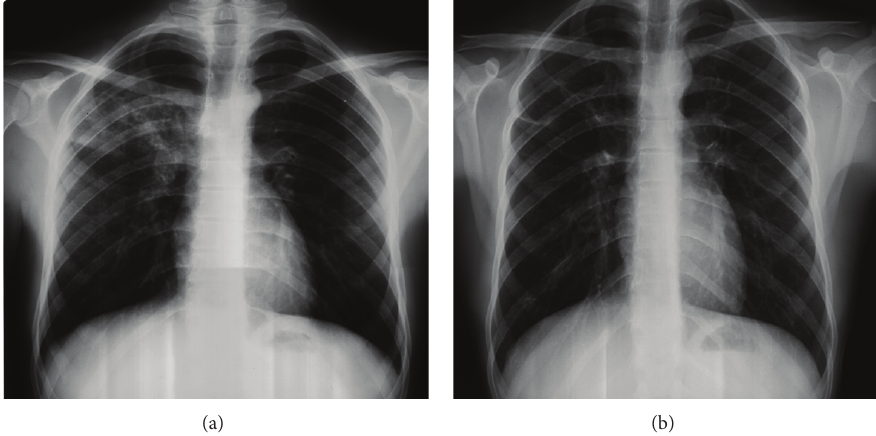
Figure 1: (a) Before antituberculosis treatment and (b) after antituberculosis